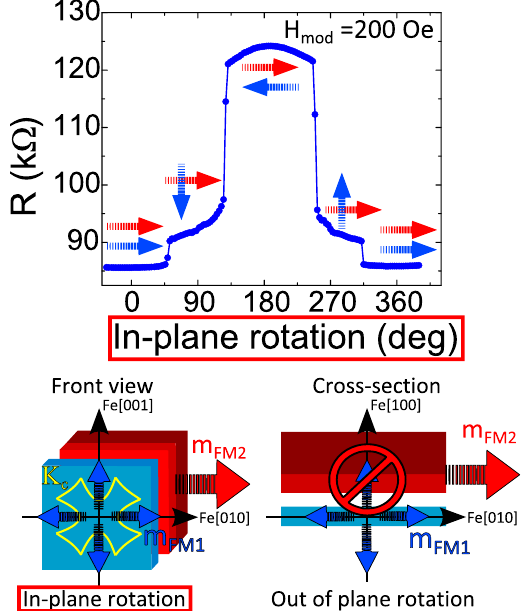
Figure 3. The top part shows the resistance vs. field curve (measured at T = 5 K) of an in-plane rotation of the external magnetic field with modulus H mod = 200 Oe. This field value maintains the hard layer practically fixed and only rotates the soft Fe layer. One observes a nearly symmetric response (sketched in the bottom left part). This excludes a possible explanation of the observed in-plane to out of plane reorientation transition (sketched in the bottom right part) in terms of the in-plane response due to magnetic field misalignment. The FM1 magnetization is depicted by blue arrows (Fe soft layer) while the FM2 magnetization is depicted by red arrows (Fe/Co hard layer).